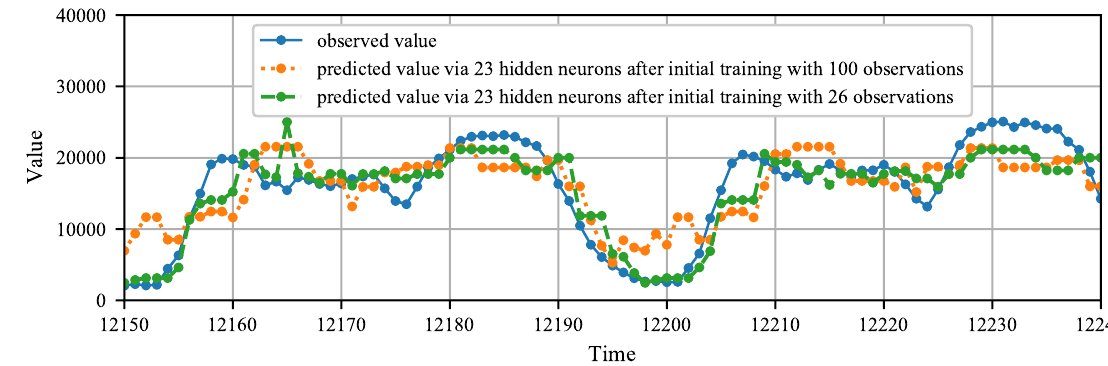
Figure 2. Time-series prediction of the online-sequential extreme learning machine (OS_ELM) over the nyc_taxi dataset.